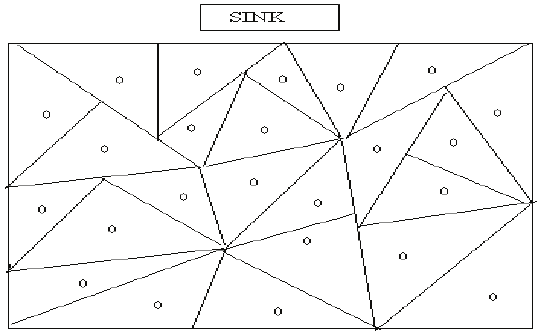
Fig 1: The Voronoi diagram for WSN.